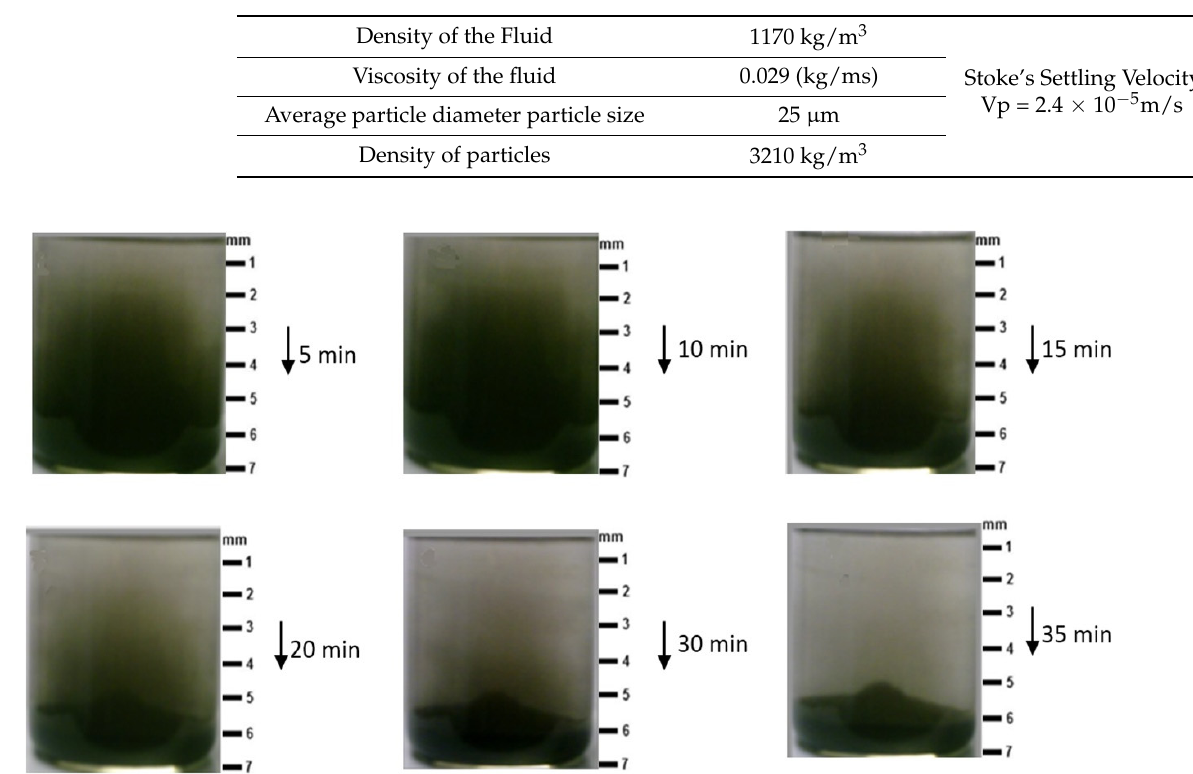
Figure 2. Settling of the SiC suspension over time: 5 min, 10 min, 20 min, 30 min, and 35 min. Table 4. Theoretical data for calculating Stoke’s settling velocity of SiC suspension in epoxy resin.